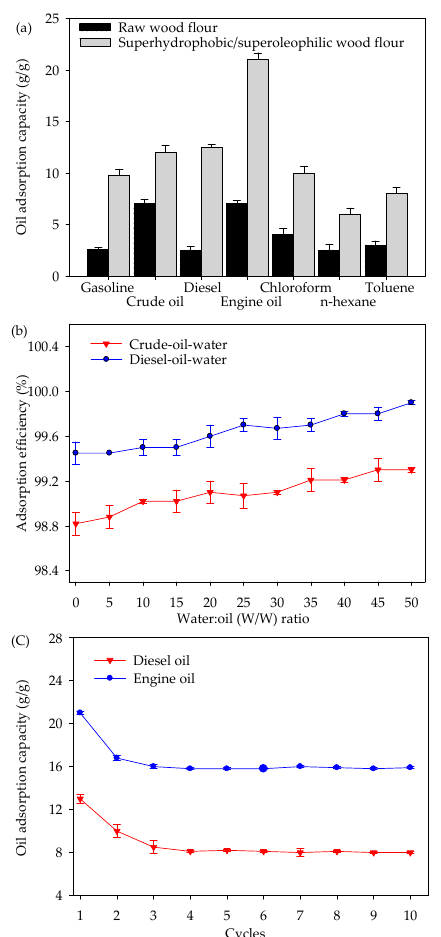
Figure 9. ( a ) The maximum adsorption capacities of the pristine and superhydrophobic/superoleophilic wood flours for various oils and organic solvents at room temperature. ( b ) The variation in adsorption efficiency (%) for diesel oil and crude oil with various mass ratios of water-to-oil. ( c ) The reusability of the superhydrophobic/superoleophilic wood flour for diesel oil and engine oil applications.